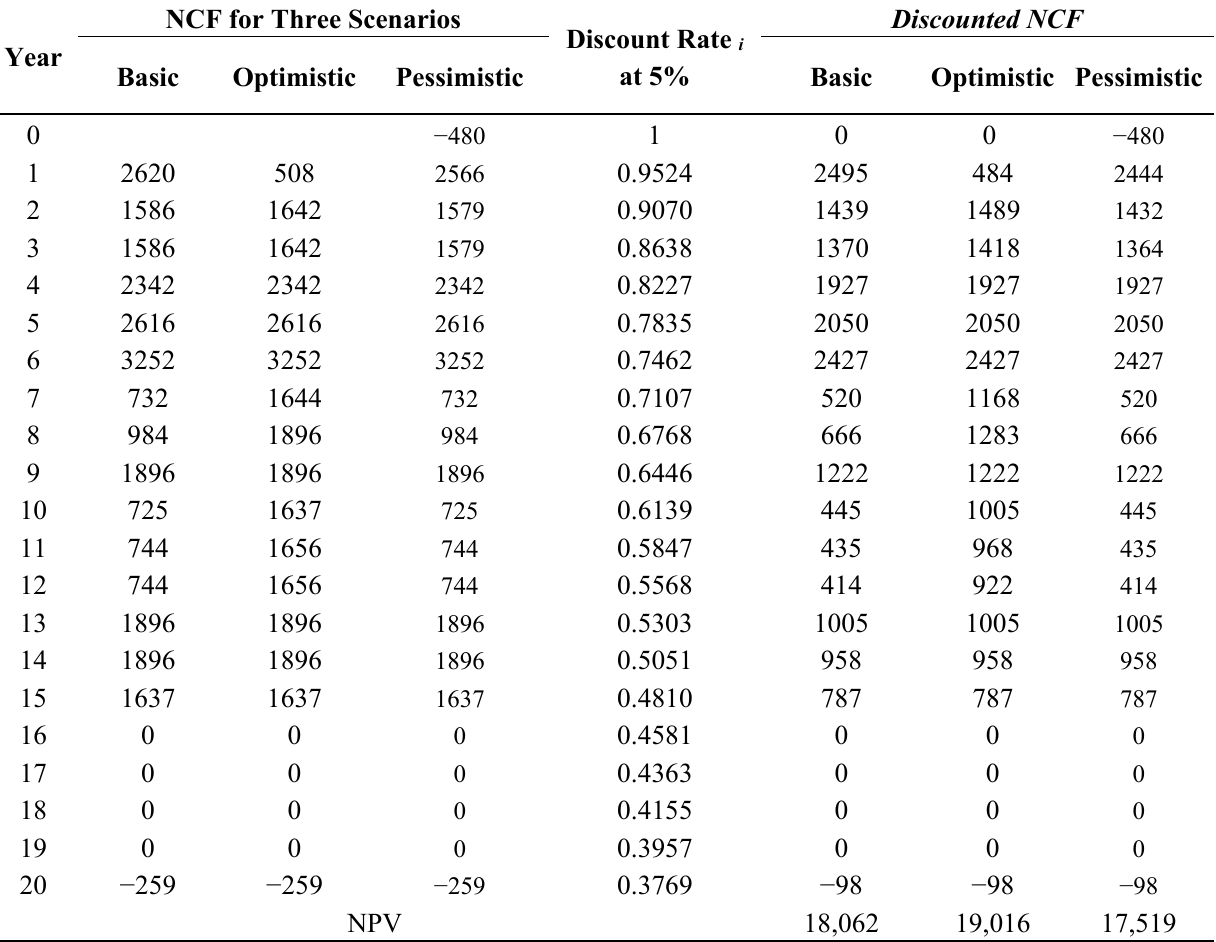
Table 3. Predicted net cash flows in subsequent years, for three scenarios (in EUR).